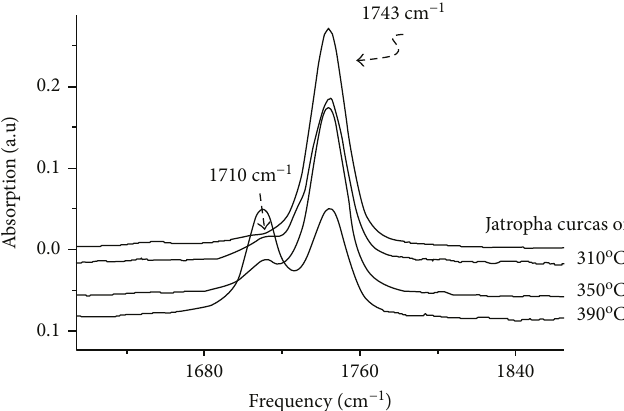
Figure 3: FTIR spectra of hydrotreated oil at di ff erent temperatures with WHSV of 3min − 1 with 20% USY/Al active phase.